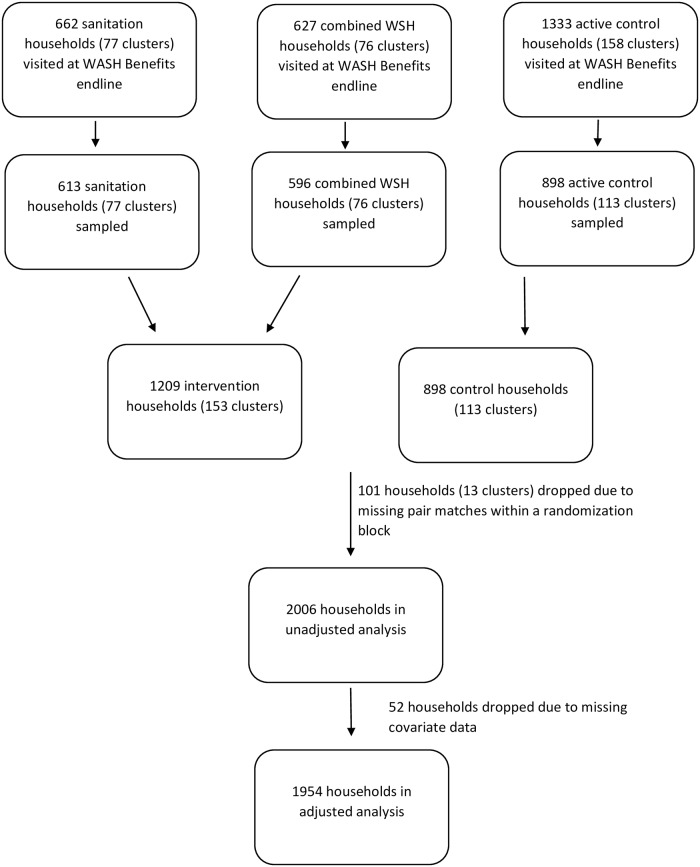
Study flow diagram.